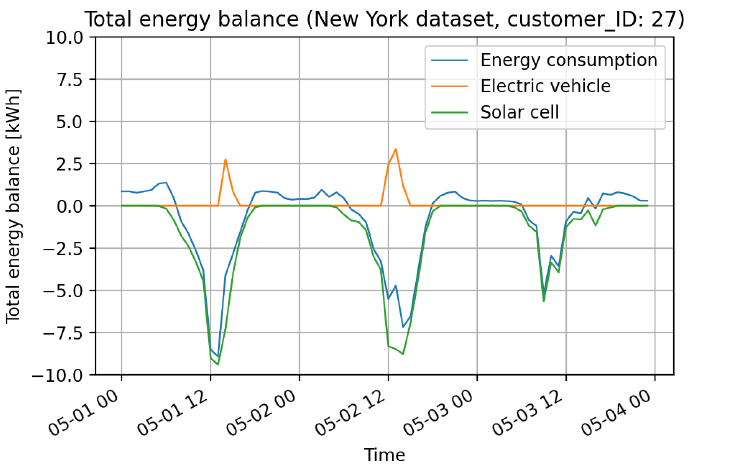
Figure 1. Comparison of the total energy balance with the charging curve of the electric vehicle and the electricity produced by the photovoltaic system for household number 27 over 72 h.